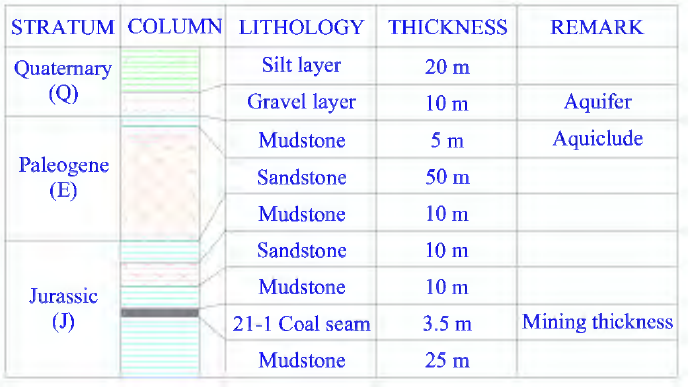
Figure 1. Coal measure lithology of LW21103.